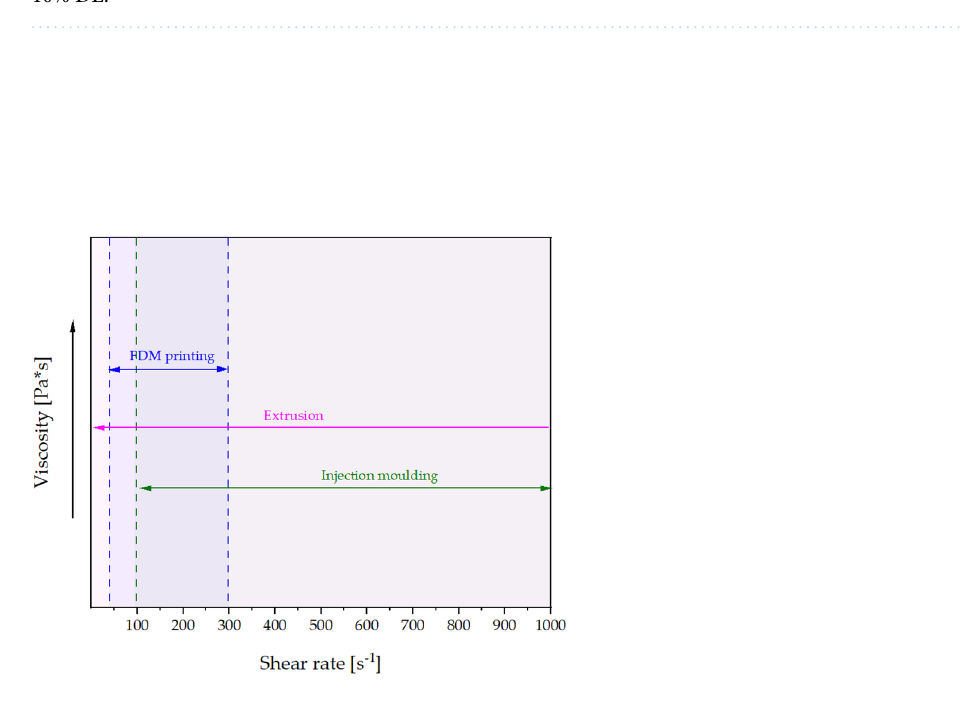
Figure 6. Areas of manufacturing technology: 3D processing area, extrusion technology area, injection moulding technology